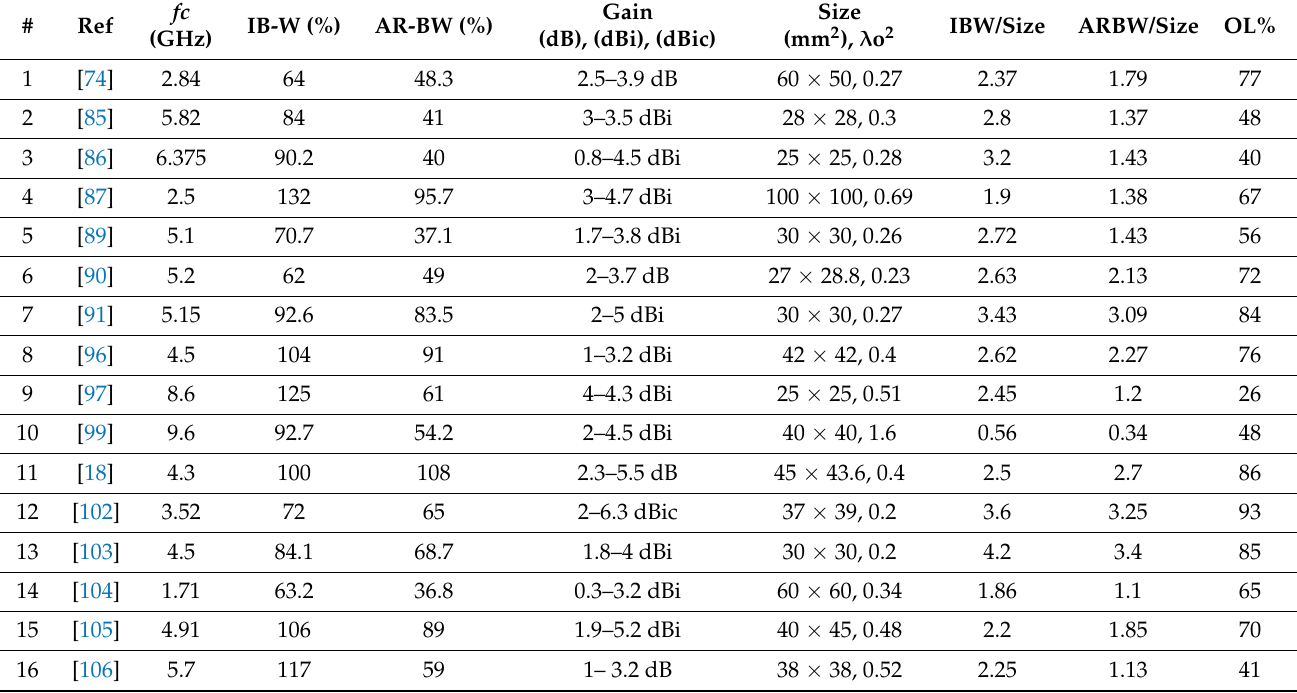
Table 2. Comparison of Existing